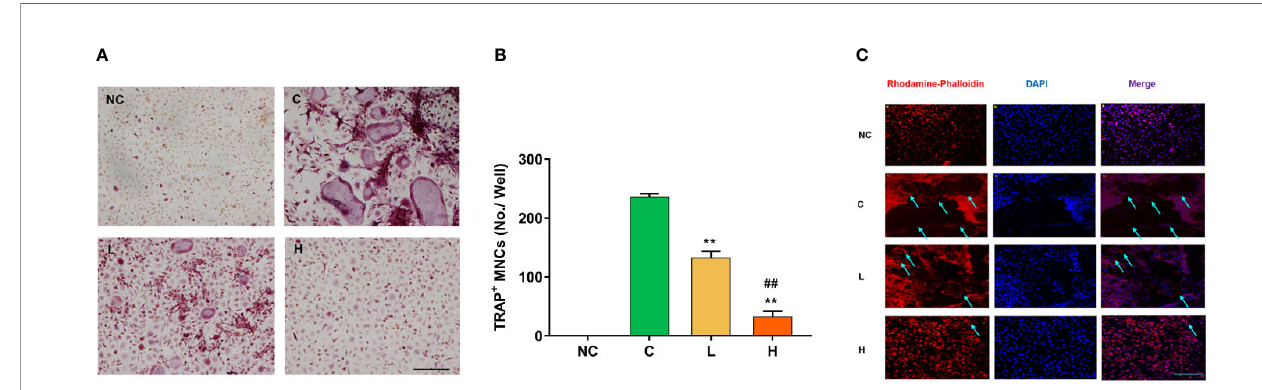
FIGURE 2 | Effects of TF3 on RANKL-induced osteoclastogenesis and F-actin ring formation in vitro . (A) BMMs were treated with M-CSF and RANKL containing various concentrations of TF3 (0, 1, 10 m M) for 5 days, and TRAP staining was then performed. (B) TRAP + multinucleated cells with more than three nuclei were counted as osteoclasts. (C) Representative images showing the F-actin formation in osteoclasts treated with TF3. n = 3, ** P < 0.01 compared with C group. ## P < 0.01 compared with L group. Scale bar =